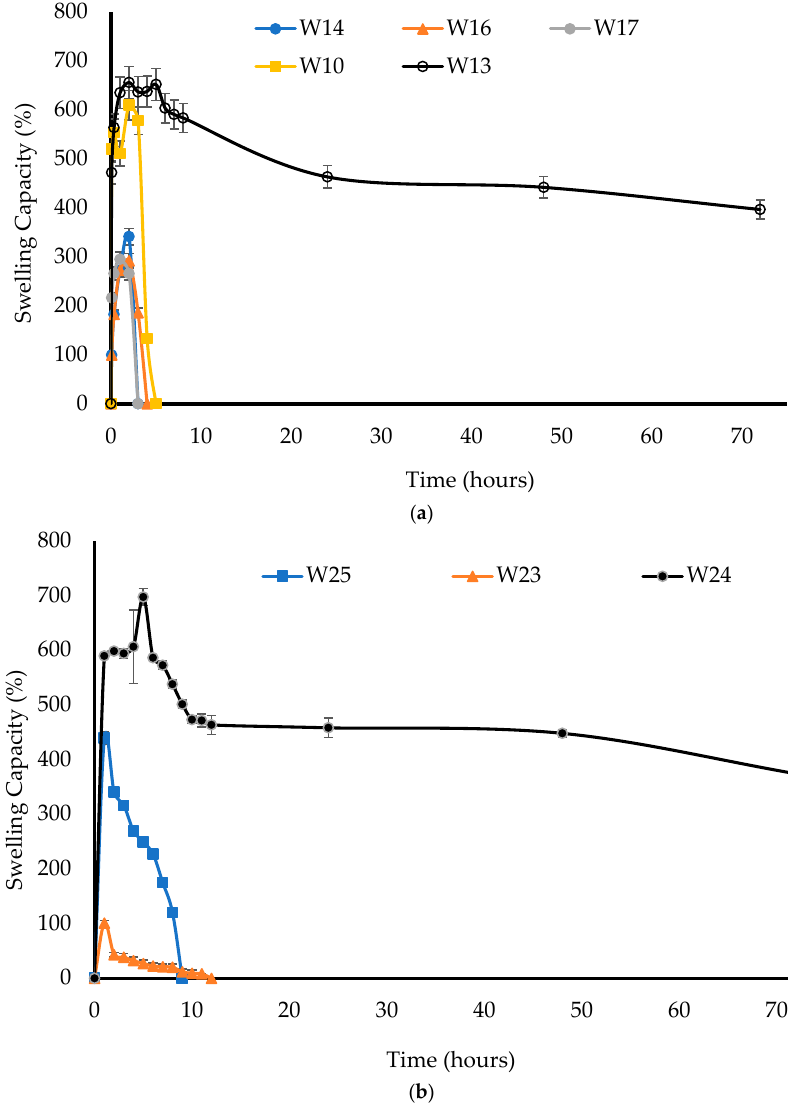
Figure 3. Swelling index of BLK ( a ) and DL ( b ) wafers.